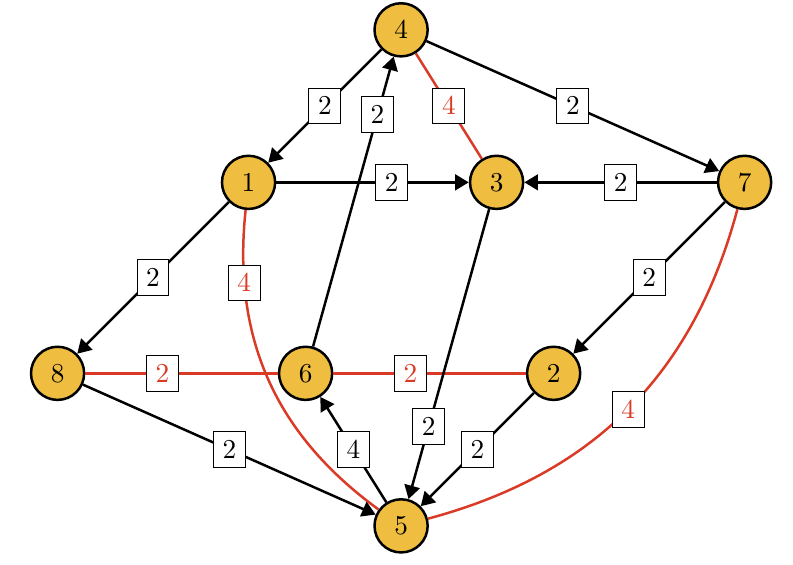
Figure 25 . Quiver diagram for phase E of Q 1 , 1 , 1 / Z 2